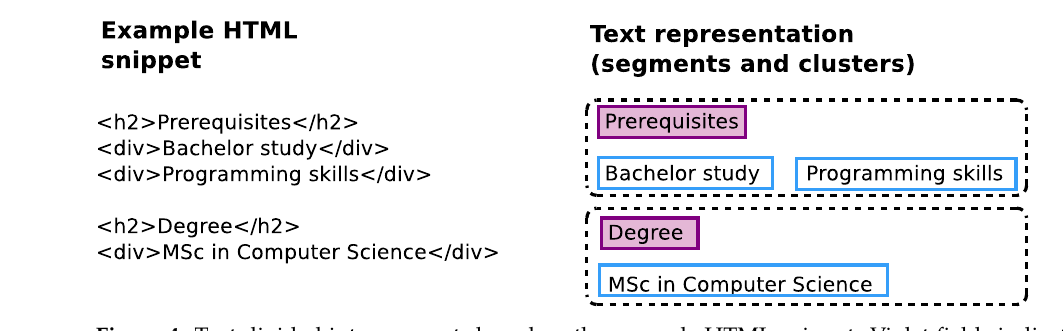
Figure 4. Text divided into segments based on the example HTML snippet. Violet fields indicate cluster titles, blue boxes the assigned content, and dashed lines cluster boundaries.